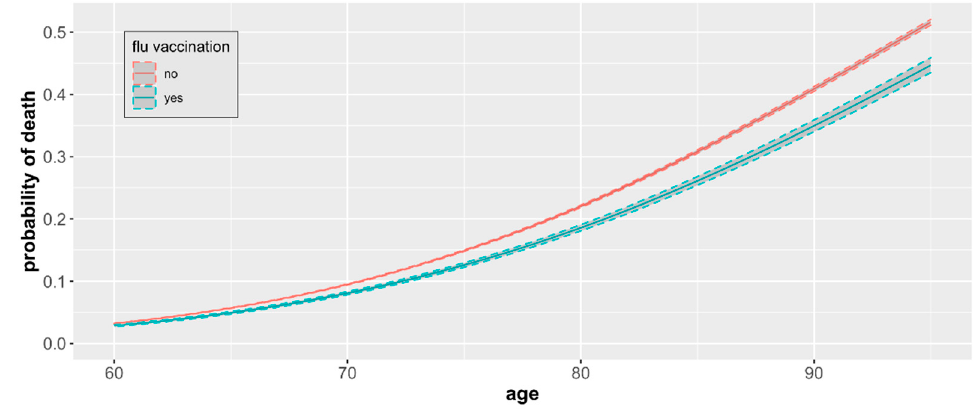
Figure 5. COVID-19 mortality by age and vaccination status. Estimates include only individuals 60+ years of age and represent differences in age group-specific mortality with 95% CIs.